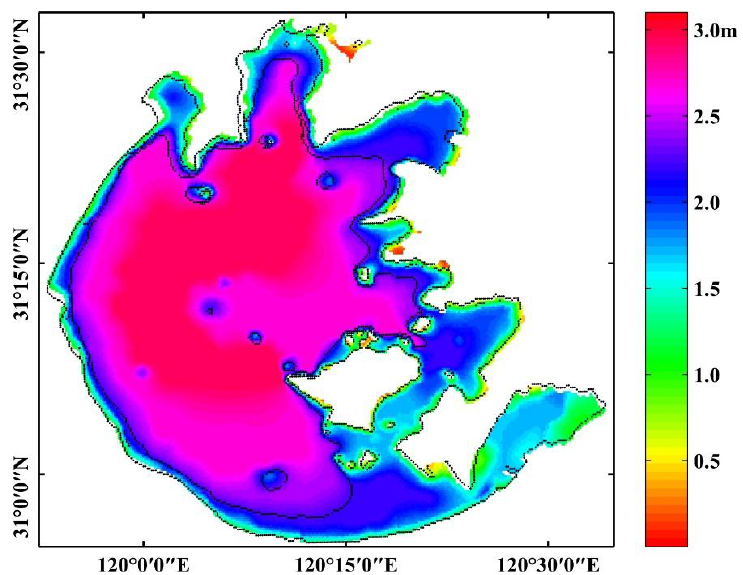
Figure 2. The 2003–2013 average depth distribution in Lake Taihu; the depth of 2.2 m is indicated by the black